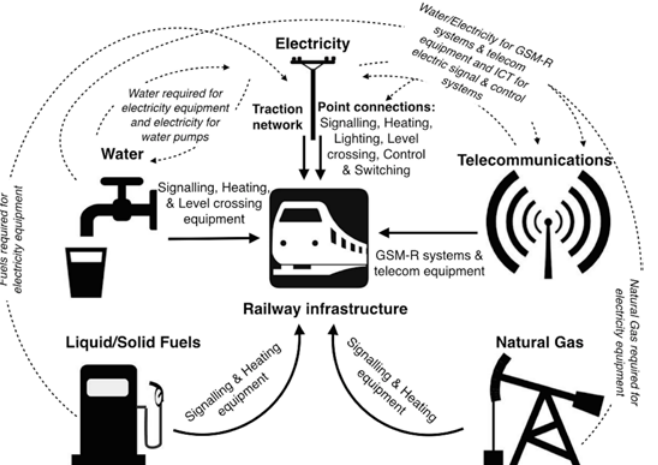
Figure 5. Interdependency mappings between infrastructures that are required for an operational railway